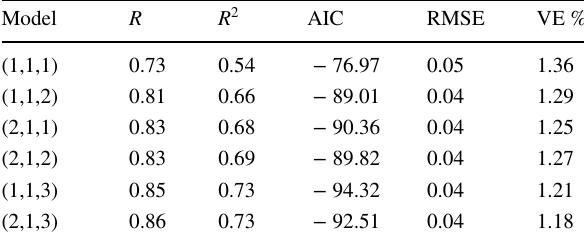
Table 2 The consequences of EC group, order (1,1)